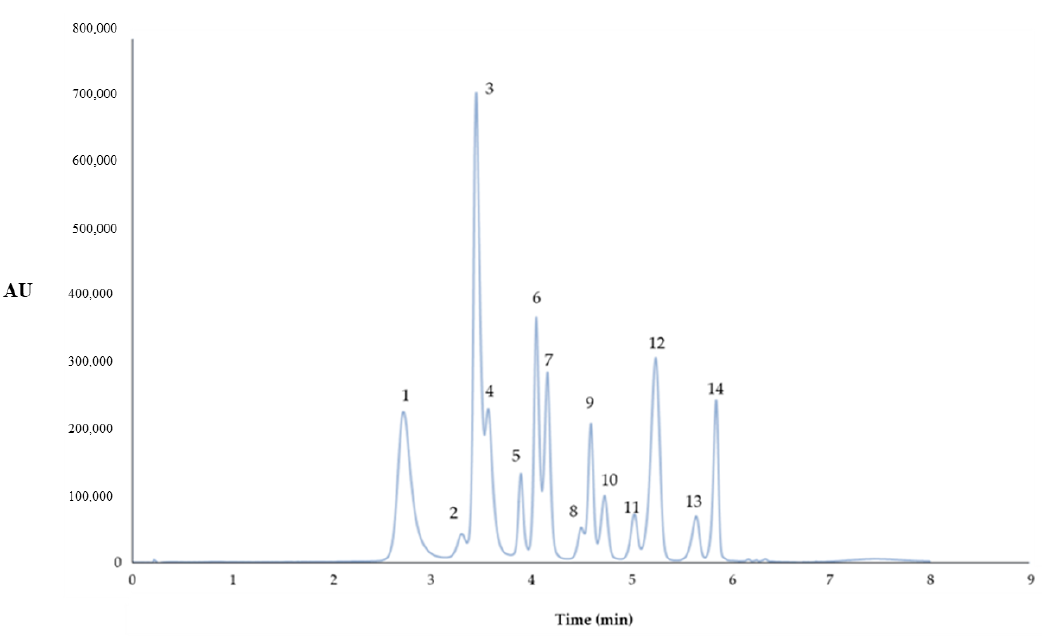
Figure 1. Ultra-high-performance liquid chromatography (UHPLC) chromatogram of the fourteen anthocyanins identified in the blueberry extract ( λ = 520 nm). Peak assignment: (1) delphinidin 3- O -galactoside; (2) delphinidin 3- O -glucoside; (3) cyanidin 3- O -galactoside; (4) delphinidin 3- O -arabinoside; (5) cyanidin 3- O -glucoside; (6) petunidin 3- O -galactoside; (7) cyanidin 3- O -arabinoside; (8) petunidin 3- O -glucoside; (9) peonidin 3- O -galactoside; (10) petunidin 3- O -arabinoside; (11) peonidin 3- O -glucoside; (12) malvidin 3- O -galactoside; (13) malvidin 3- O -glucoside; (14) malvidin 3- O -arabinoside; AU—Absorbance units.